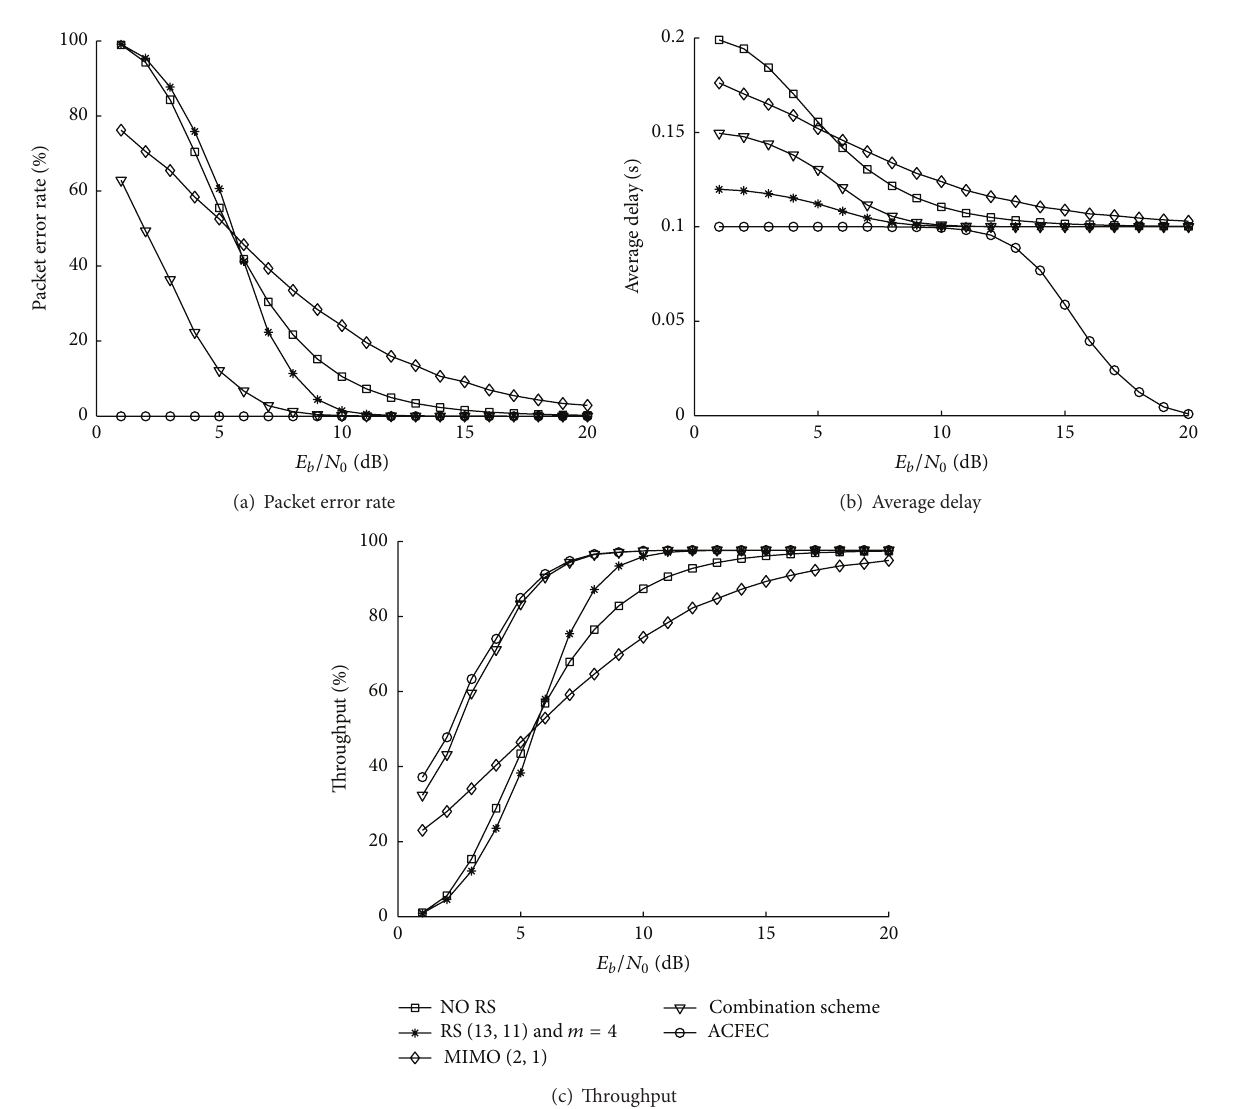
Figure 5: Performance with varying